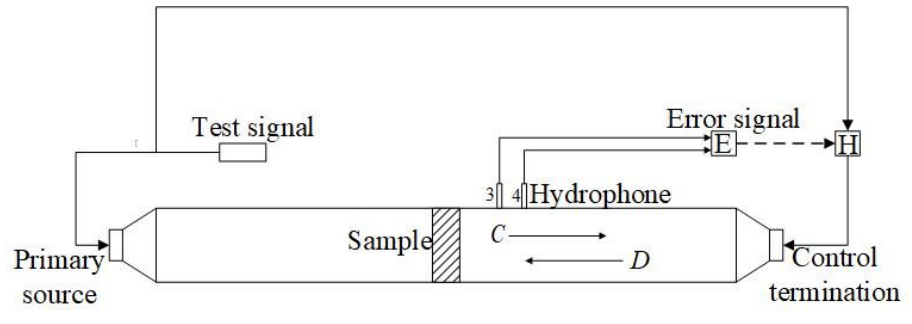
Figure 2. Transfer function method measurement